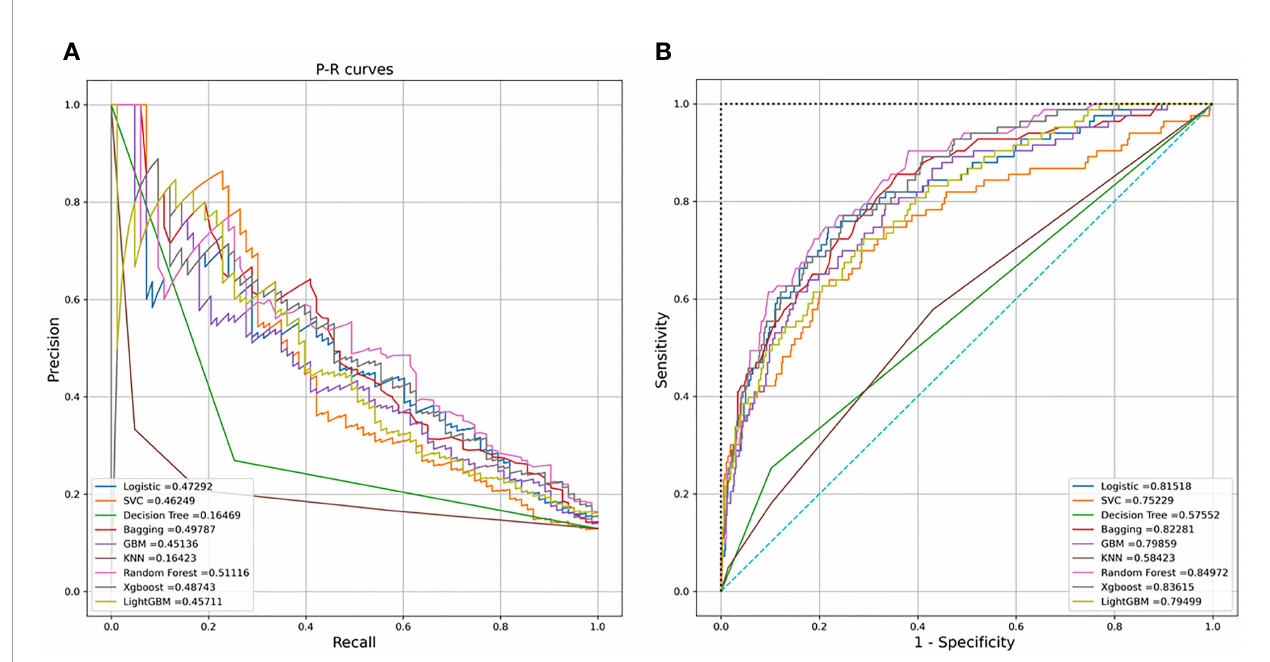
FIGURE 3 | (A) Receiver operating characteristic (ROC) curves of the nine models. (B) Precision-Recall (P-R) curves of the nine